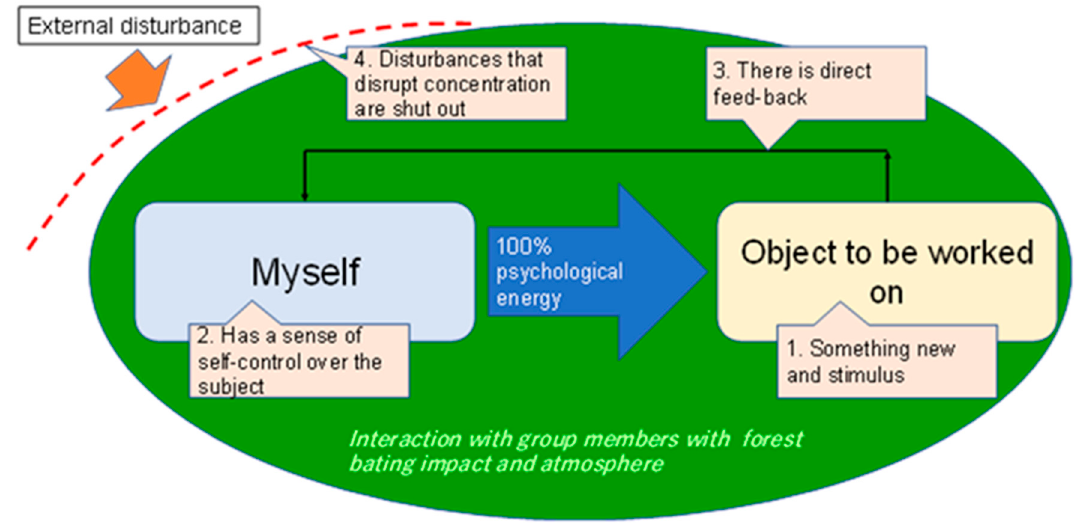
Figure 11. ‘Flow’, with an impact on learners’ concentration.